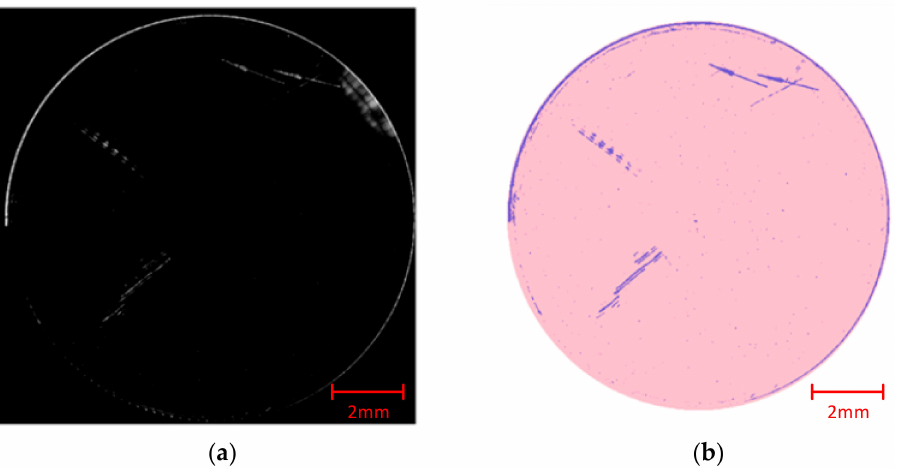
Figure 16. ( a ) The stitching result of original images on inspection of a tested surface; ( b ) The distribution map of extracted defects on the tested